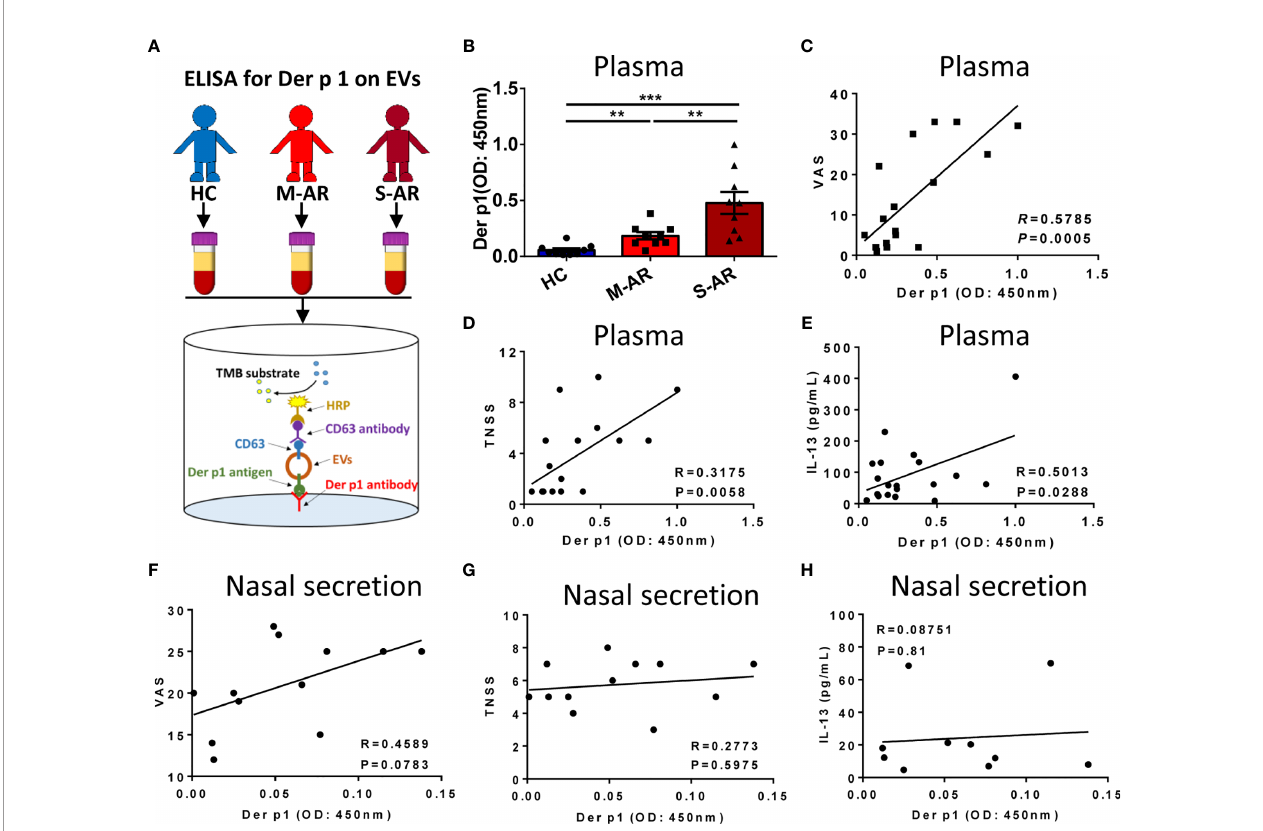
FIGURE 4 | Detection of Der p 1-carrying EVs and the correlation between Der p 1 + EVs with the signs of the diseases and level of IL-13 in AR patients. (A) Schematic diagram of the ELISA for detection of Der p 1 on plasma EVs. (B) Levels of Der p 1 in patients with M-AR and S-AR were both signi fi cantly higher than HC subjects, as determined by ELISA. (C – E) Level of plasma EV-bearing Der p 1 in AR patients was signi fi cantly correlated with the VAS score (C) , TNSS score (D) , and level of IL-13 in plasma (E) . (F – H) Level of Der p 1 on nasal secretion-derived EVs in AR patients has no signi fi cant correlation with VAS score (F) , TNSS score (G) , and level of IL-13 in nasal secretion (H) . ELISA, Enzyme-linked immunosorbent assay; EVs, Extracellular vesicles; HC, Healthy control; M-AR, Mild allergic rhinitis; S-AR, Moderate-severe allergic rhinitis; TNSS, Total nasal symptom score; VAS, Visual analogue scale. ** p < 0.01, *** p < 0.001 by one-way ANOVA multiple comparison. Correlation analyses were performed using Pearson correlation coef fi